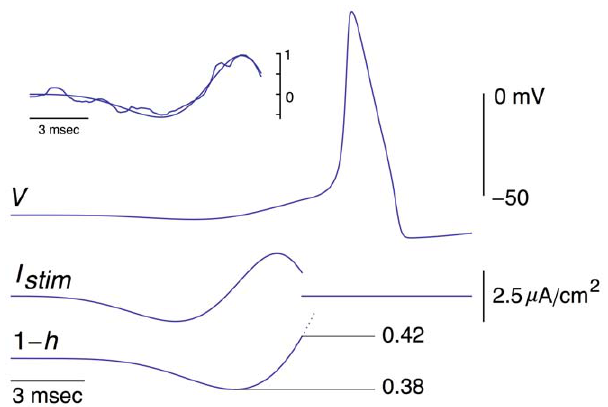
Figure 2. Inset: Another example of an optimal stimulus obtained from a different preparation than the one used in Figure 1. This result is shown superimposed on an ad hoc description of this waveform by the expression f ( t )= a sin(( bt ) 2 (exp( ct ) 2 1) with a =202 (arbitrary units; this value was chosen so that the maximum amplitude of f is 1, b =0.2 msec 2 1 , and c =0.00045 msec 2 1 . The experimental result has also been scaled so that its maximum value is 1. The response of the Hodgkin and Huxley model to f ( t ) is shown, tracing V , with a =610 mA/cm 2 . Below that result is the stimulus f ( t )= I stim , and 1 2 h . The dashed line indicates that the h variable continues to change throughout the simulation.